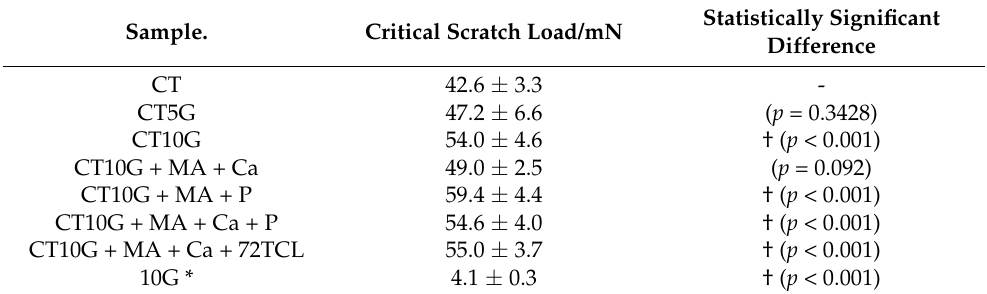
Figure 5. XRD profiles of surfaces of Ca–heat-treated Ti–6Al–4V alloy soaked in SBF for 7 days fol- lowing dip coat treatment with various additives. When the 10%-DC samples with the additives of Ca or P were subjected to TCL treat- ment, the former maintained its apatite formation even after 72 h of TCL treatment (Figure 6). On the contrary, the latter lost its apatite formation within 3 h of TCL treatment.